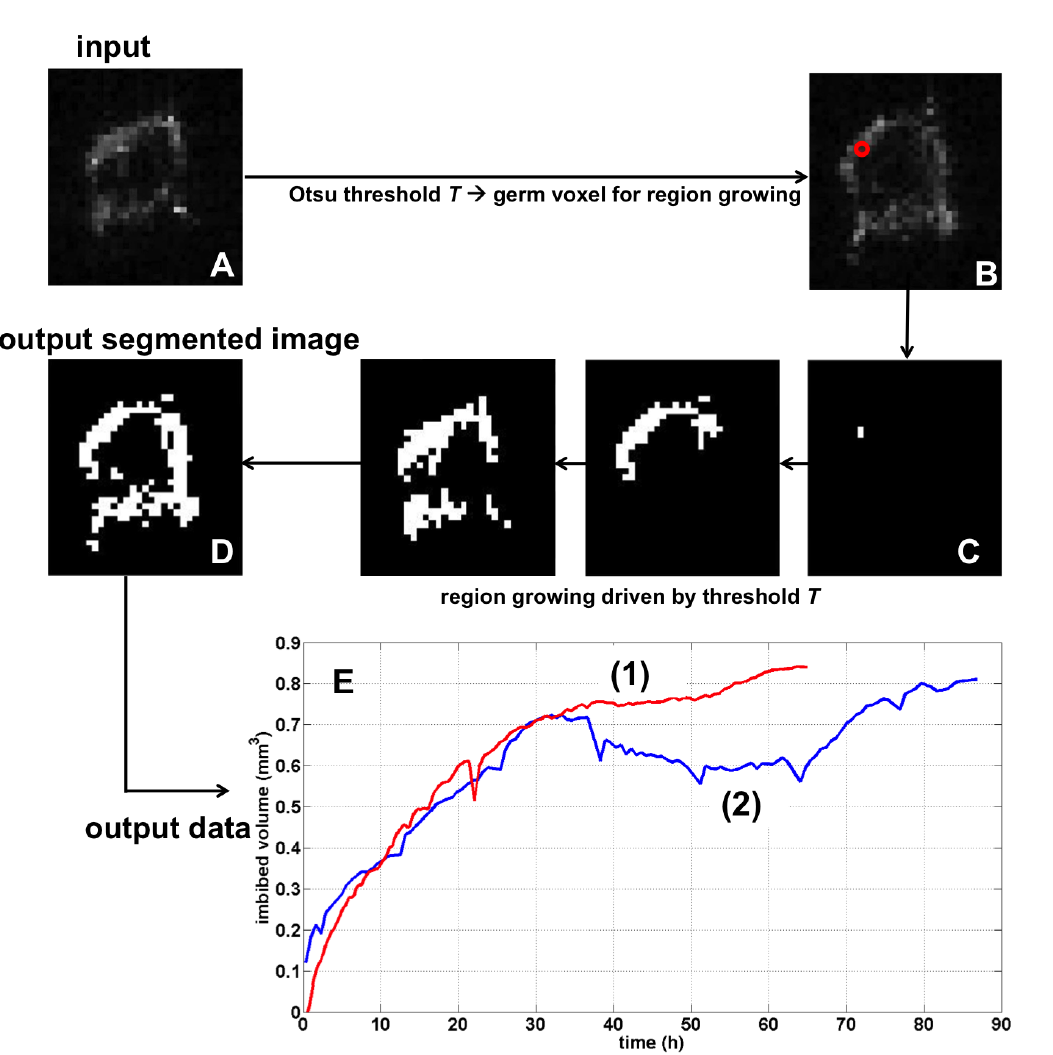
Figure 2. Main steps of the image processing pipeline performing 3D segmentation of the MRI images. The pipeline is illustrated with a 2D slice of 128 × 128 pixels from a 3D MRI image of 128 × 128 × 64 voxels. The output data show the temporal evolution over the imbibition process of the imbibed volume in two different sugar beet seeds (1) and